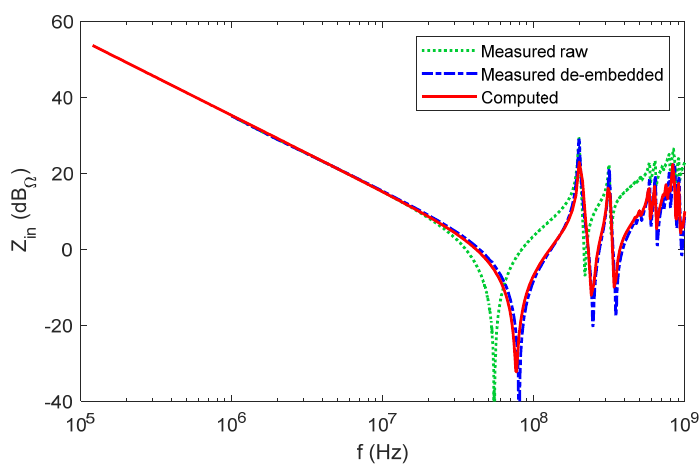
Figure 10. Comparison between measured and simulated input impedance at Port 2 for the case of the bare board.